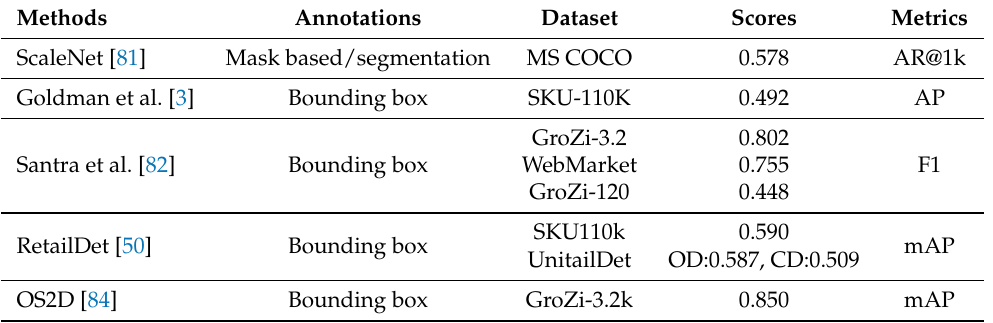
Table 4. Comparison of grocery product detection methods. In the RetailDet, the evaluation was made in two test sets, the origin-domain, which is represented as OD, and cross-domain as CD. Methods